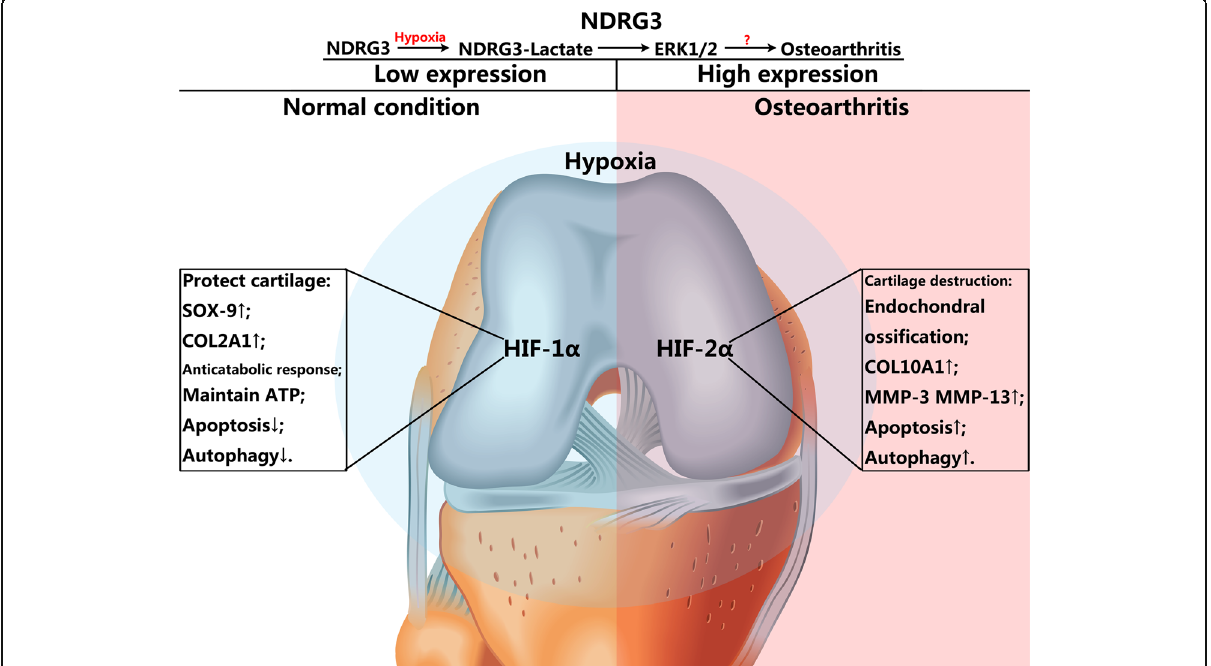
Fig. 7 NDRG3 may be closely related to the development and progression of